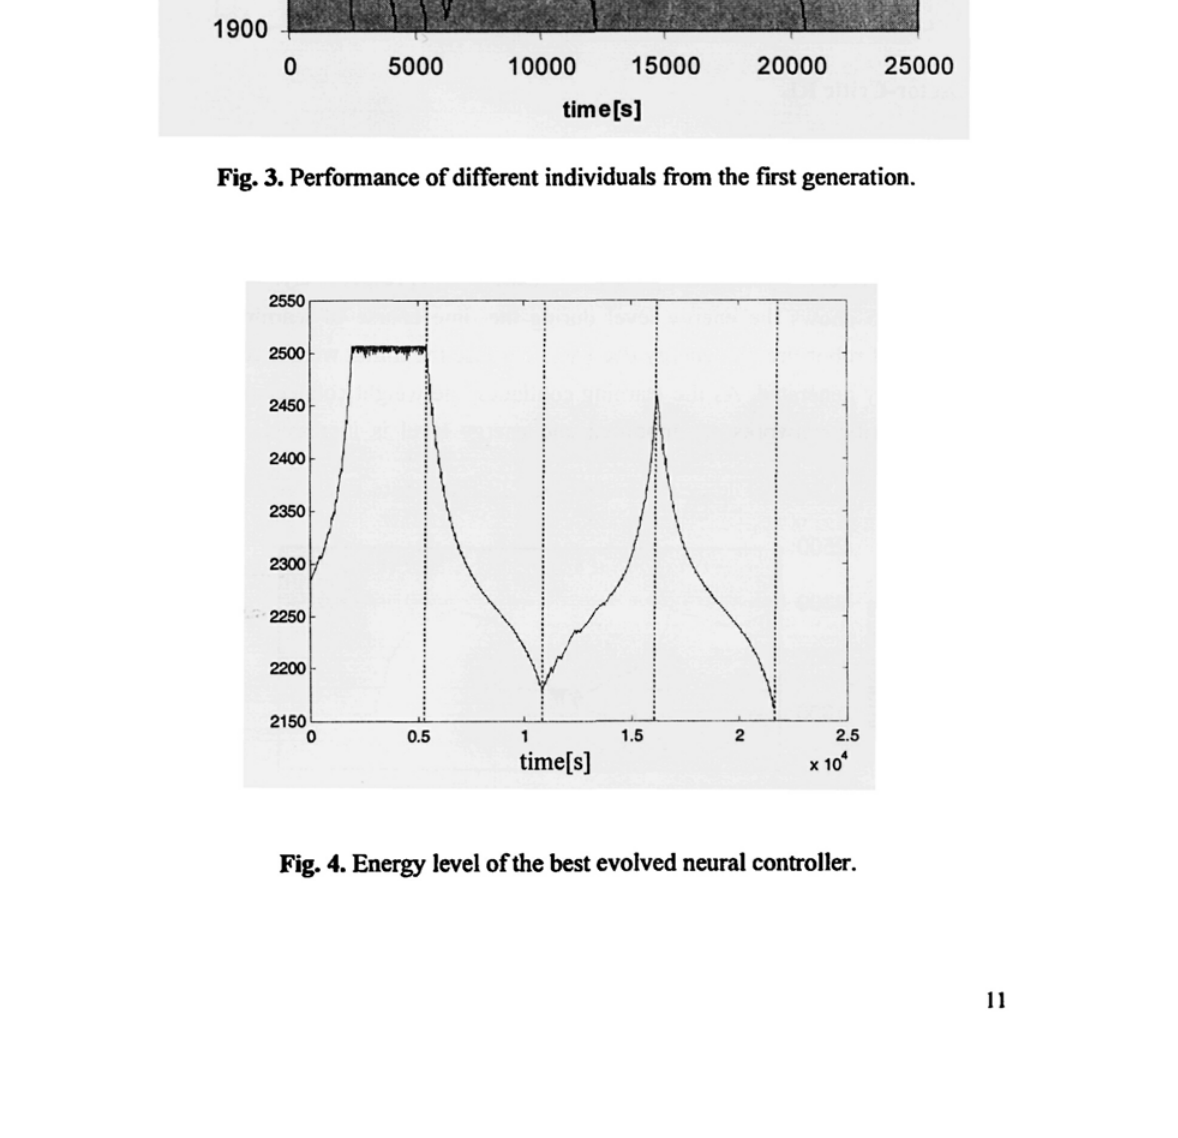
Fig. 4. Energy level of the best evolved neural